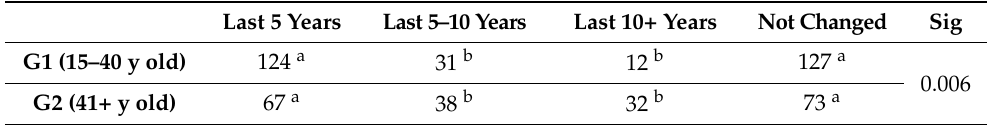
Table 5. Response to the question ‘Do you feel your feeding practices have changed in the last 10